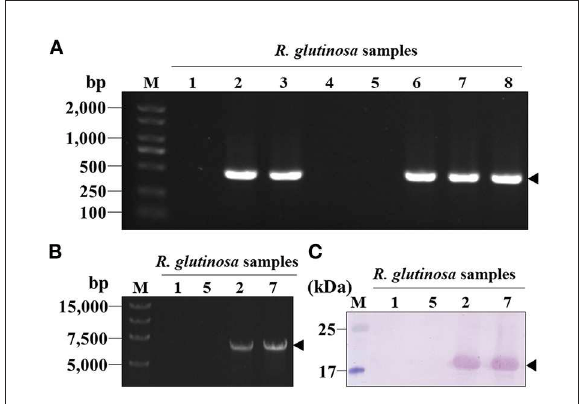
FIGURE3 Screening for the ReMV-infected and non-infected R. glutinosa plants. (A) Agarose-gel analysis of the RT-PCR products from eight R. glutinosa plants collected from the field. The amplicon position of the CP coding region sequence was indicated by a black arrowhead. (B) Agarose-gel analysis of the selected R. glutinosa samples 1#, 2#, 5#, and 7# by RT-PCR using the primers corresponding to full-length cDNA of ReMV genomic RNA. (C) Western blot analysis of the R. glutinosa samples 1#, 2#, 5#, and 7# using the crude antiserum against CP of ReMV (diluted 20,000-fold). M, DNA or protein markers.